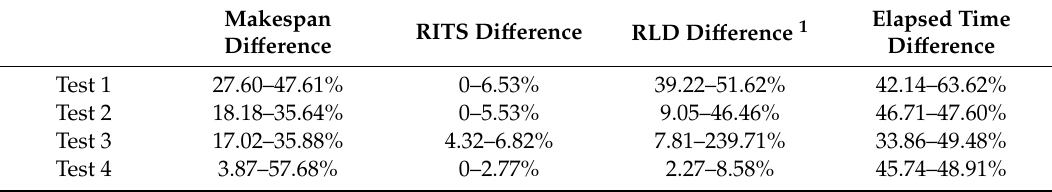
Table 13. Percentage differences between various indicators and their worst values.